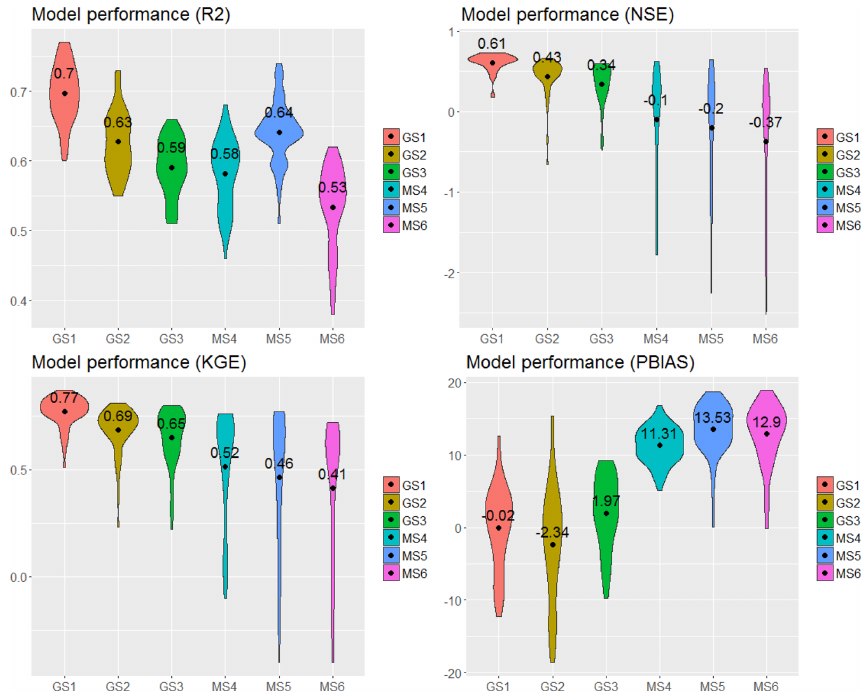
Figure 8. Plots of the performance result of SWAT in simulating actual evapotranspiration. The values and the black dot symbols ( • ) depict the average value of R 2 , NSE, KGE and PBIAS obtained for each calibration.